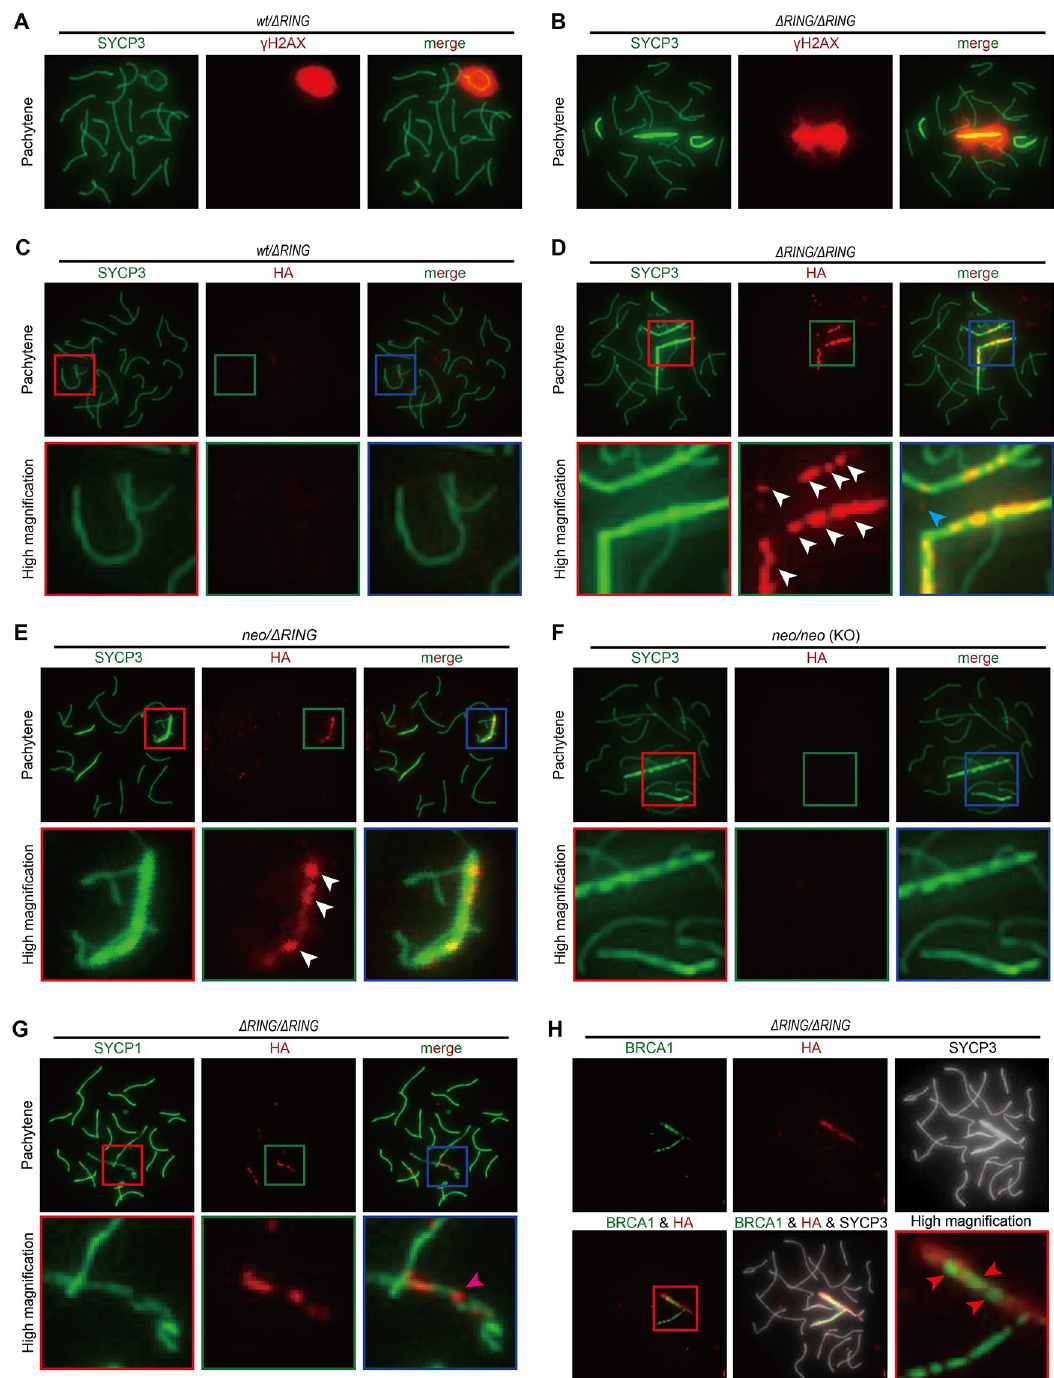
Fig 7. Cytological analysis of Trim41 Δ RING/ Δ RING spermatocytes. (A and B) SYCP3/ γ H2AX immunostaining of pachytene stage spermatocytes from Trim41 wt/ Δ RING (A) and Trim41 Δ RING/ Δ RING (B) male mice. At least three male mice were analyzed. (C–F) SYCP3/HA immunostaining of pachytene spermatocytes from Trim41 wt/ Δ RING (C), Trim41 Δ RING/ Δ RING (D), Trim41 neo/ Δ RING (E), and Trim41 neo/neo (KO; F) male mice. White and blue arrowheads indicate HA signals on and outside of SYCP3 axes, respectively. High magnified images are shown in red, green, and blue boxes. At least three male mice were analyzed for Trim41 wt/ Δ RING and Trim41 Δ RING/ Δ RING . (G) SYCP1/HA immunostaining of surface chromosome spread from Trim41 Δ RING/ Δ RING testis. Magenta arrowheads indicate HA signals on the SYCP1 positive/negative boundary. High magnified images are shown in red, green, and blue boxes. At least three male mice were analyzed. (H) BRCA1/HA immunostaining of surface chromosome spread